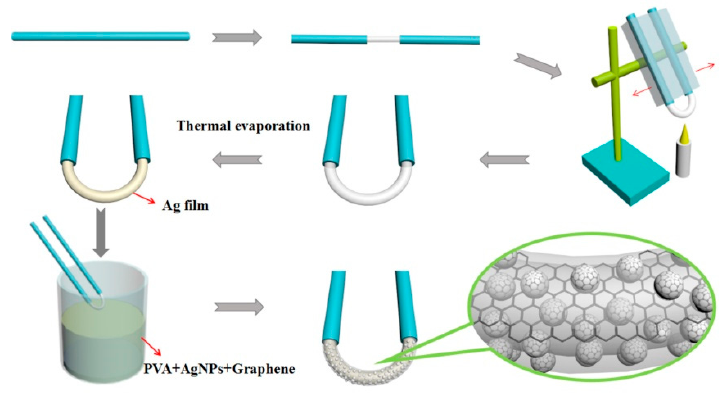
Figure 4. Fabrication process of U ‐ shaped LSPR sensor probe [45].